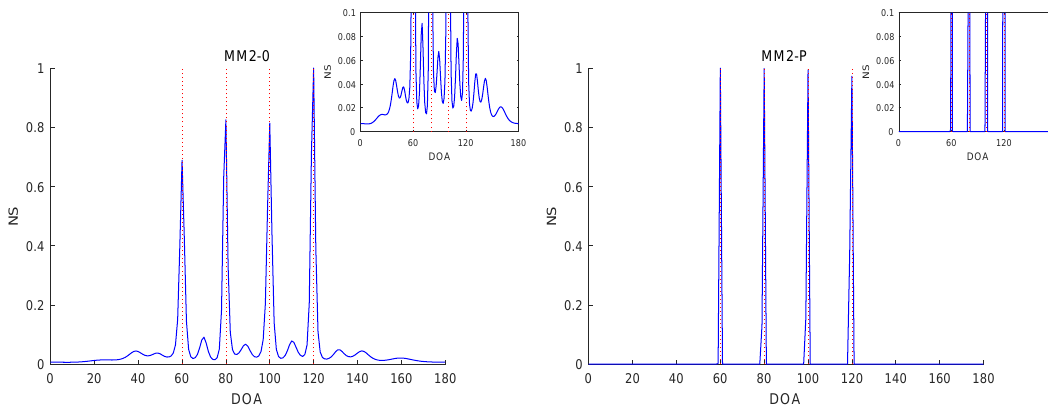
Figure 6. NSs of Experiment 1 with SNR = 0